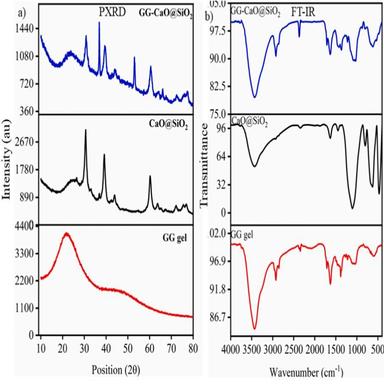
(a) PXRD (b) FT-IR spectrum of guar gum (GG), CaO@SiO2 and GG- CaO@SiO2.